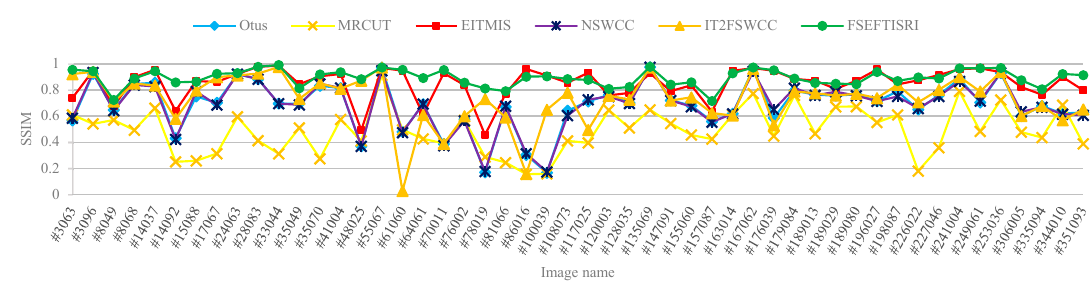
Figure 20. Comparison of SSIM of several algorithms.